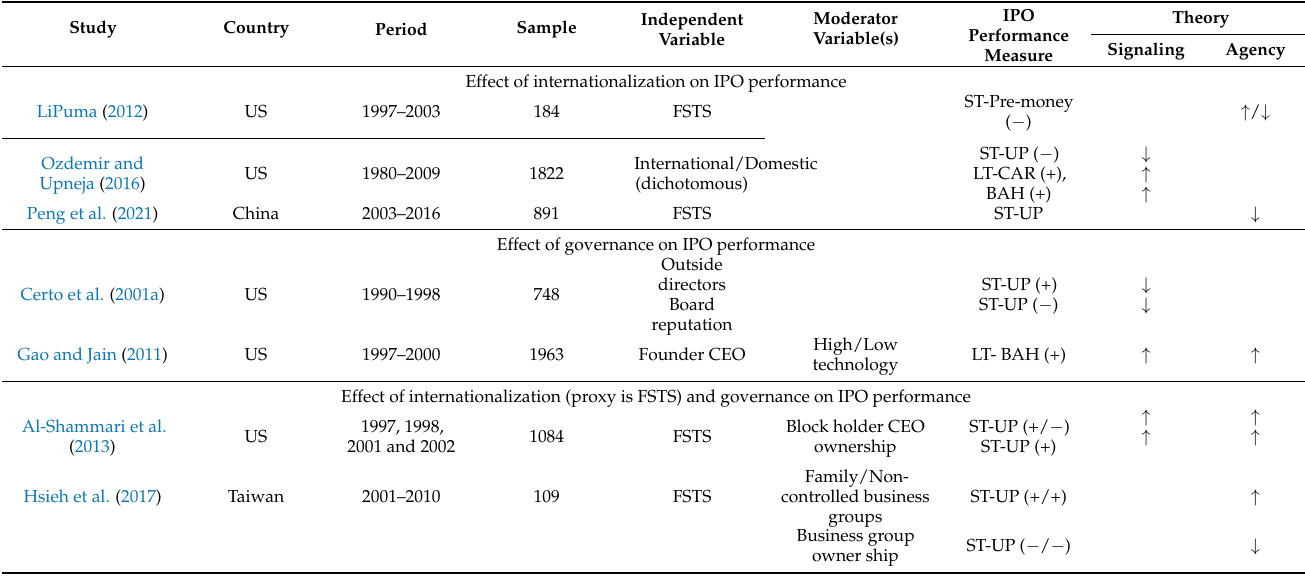
Table 1. Determinants of IPO performance and related